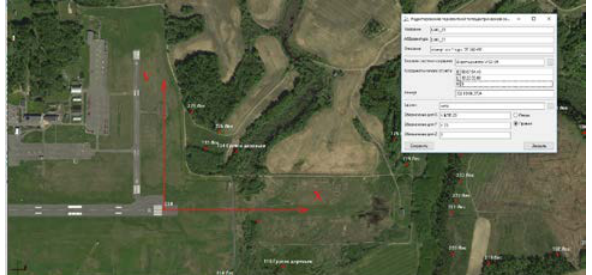
Figure 5 The local topocentric coordinate